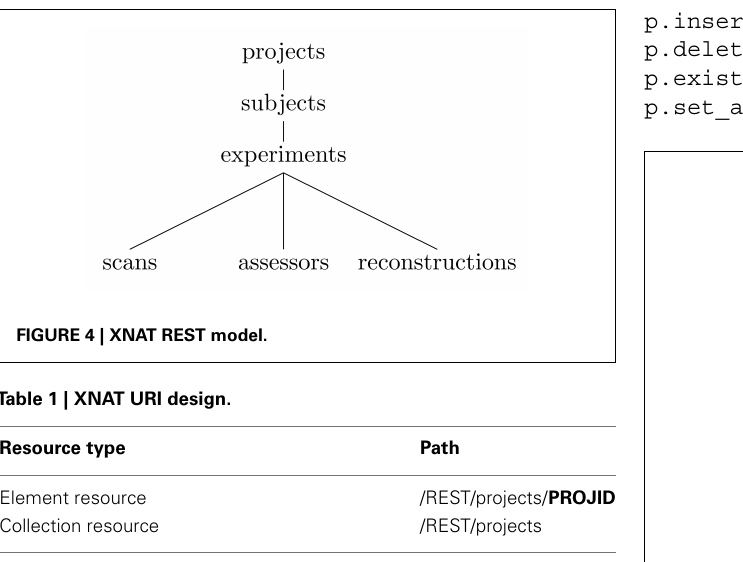
Table 2 | URI query strings usage in